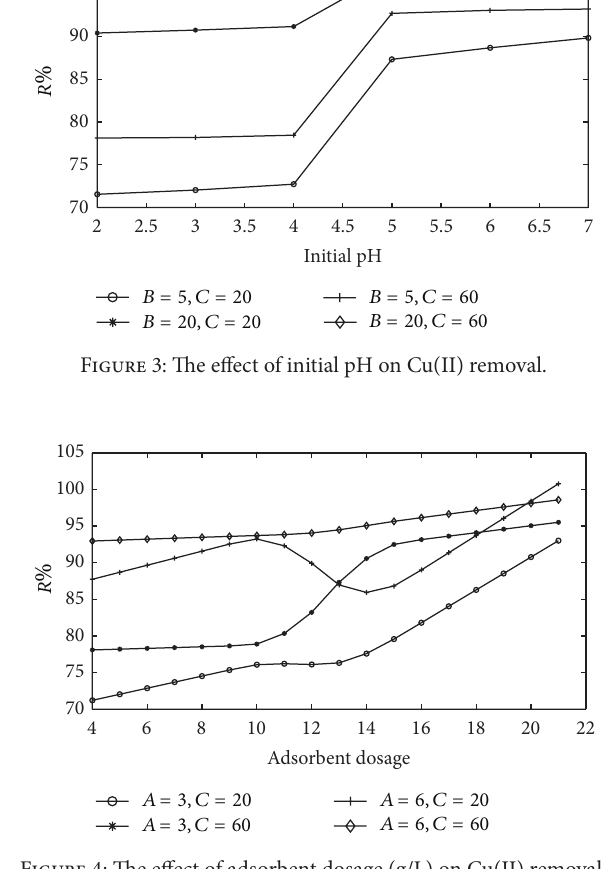
In Figure 1, the first layer is the input layer. Initial pH, adsorbent dosage, and temperature are the inputs of the experimental procedure. The whole experimental design used in ANFIS and statistical calculations are given in Table 2.